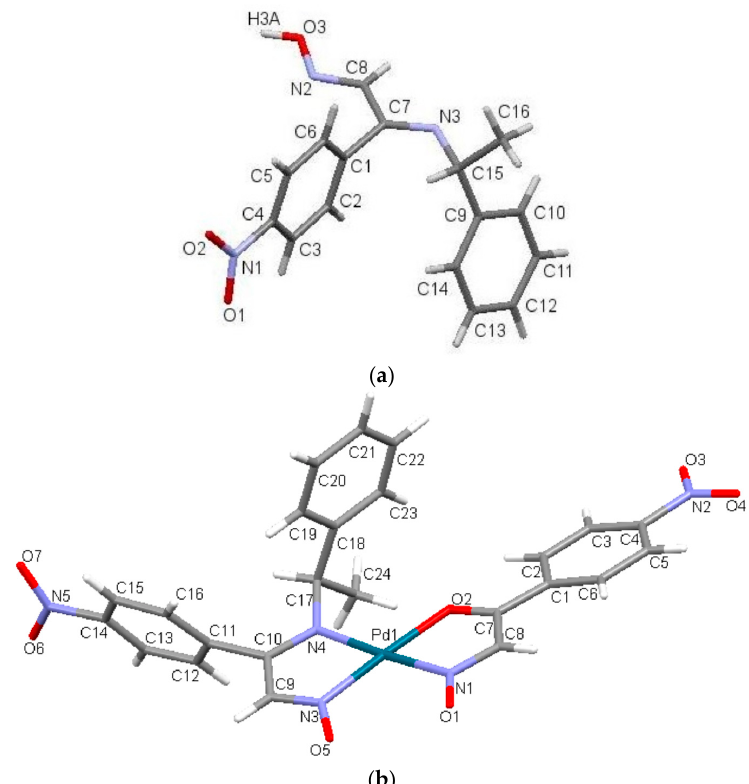
Figure 5. ( a ) Molecular view of nppeieoH. Selected bond lengths (Å) and (°): O3–H3a 0.913(3),